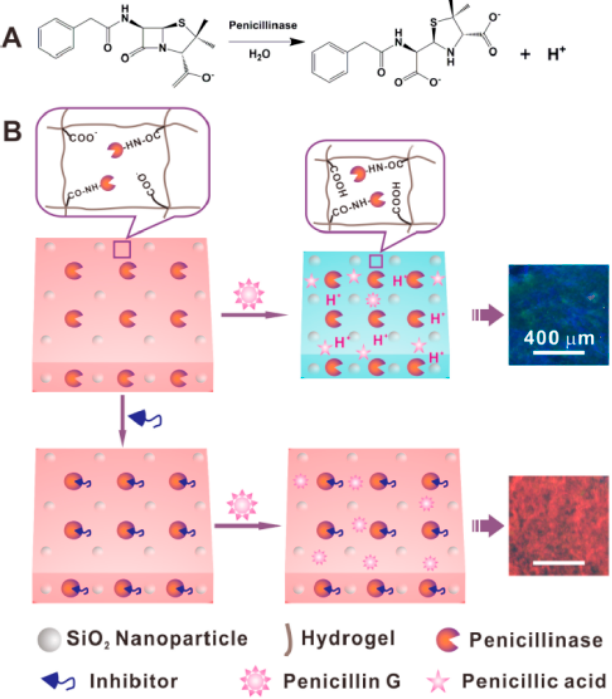
Figure 15. ( A ) Enzymatic reaction between penicillinase and penicillin G; ( B ) Schematic illustration of the PCCH (penicillinase colloidal crystal hydrogel) sensor for the detection of β -lactam antibiotic and β -lactamase inhibitor. Reproduced with permission from